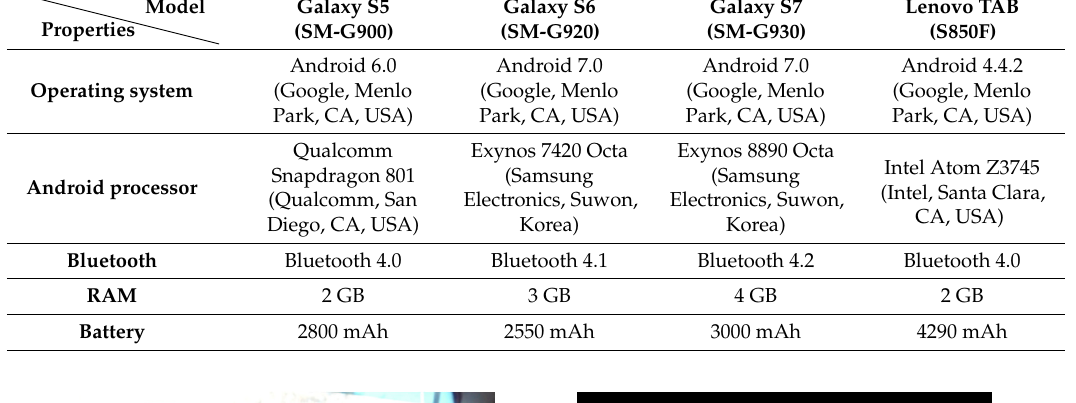
Table 3. Specifications of mobile devices used for testing the BBUNS application.